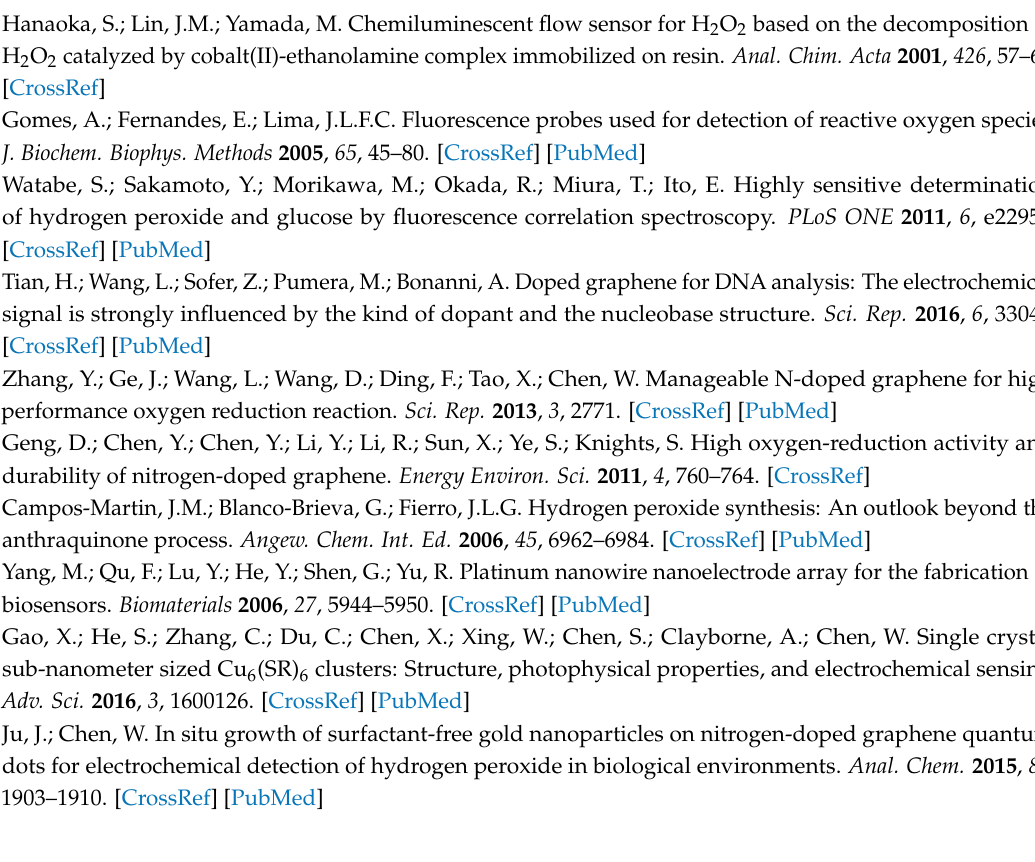
Figure S1: Nyquist Plots of the Electrochemical Impedance Spectroscopy (EIS) for the Toray, Mechanically Treated CNF, and Pure PAN CNF electrodes. The equivalent electrical circuit is shown in the inset. In equivalent circuit, R i represents the internal resistance, R sf represents the surface resistance, C sf represents the surface Capacitance, and R ct represents the charge-transfer resistance. The double layer capacitance (C dl ) is modeled as a Constant Phase Element (CPE) and diffusion affects are represented by the Warburg element (W), Table S1: Double layer capacitance, Geometric Surface Area, and Active Surface Area of electrodes, Figure S2: Wide XPS spectrum of the mechanically treated CNF, Figure S3: High resolution O 1s XPS spectra of mechanically treated